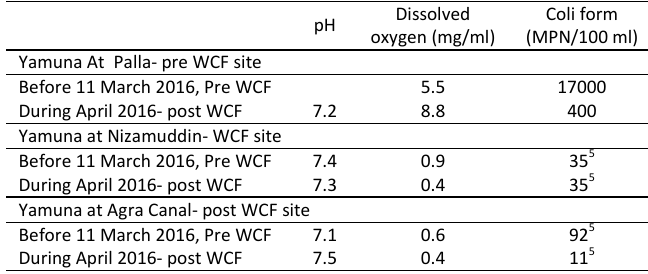
Table 2: Water status just pre (March) and post WCF (April) at Yamuna Dissolved pH oxygen (mg/ml)